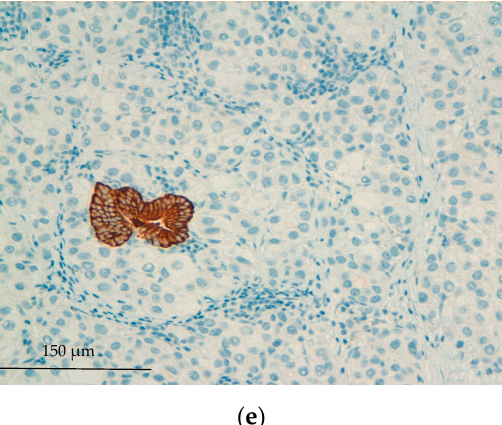
Figure 3. Histopathology images: ( a ) H&E stain, zoom 5×. Solid and trabecular epithelioid neoplasm with peripheral hemorrhage and dilated small vessels corresponding to peduncle. Note the presence of perivascular small lymphocytes aggregates; ( b ) H&E stain, zoom 30×. Solid area. The cells show atypical nuclei with frequent nuclear pseudoinclusions; ( c ) arginasea1 immunohistochemistry stain, zoom 5×: strong and diffuse cytoplasmic positivity in tumor cells that confirm the hepatocellular differentiation of neoplastic cells; ( d ) glypican3 immunohistochemistry stain, zoom 5×: strong and diffuse membranous positivity in tumor cells that support the malignant nature of hepatocellular proliferation. ( e ) CK19 immunohistochemistry stain, zoom 30×: absence of reactivity in the neoplastic cells, with positive internal control in a non-neoplastic ductal structure. H&E: hematoxylin and eosin.